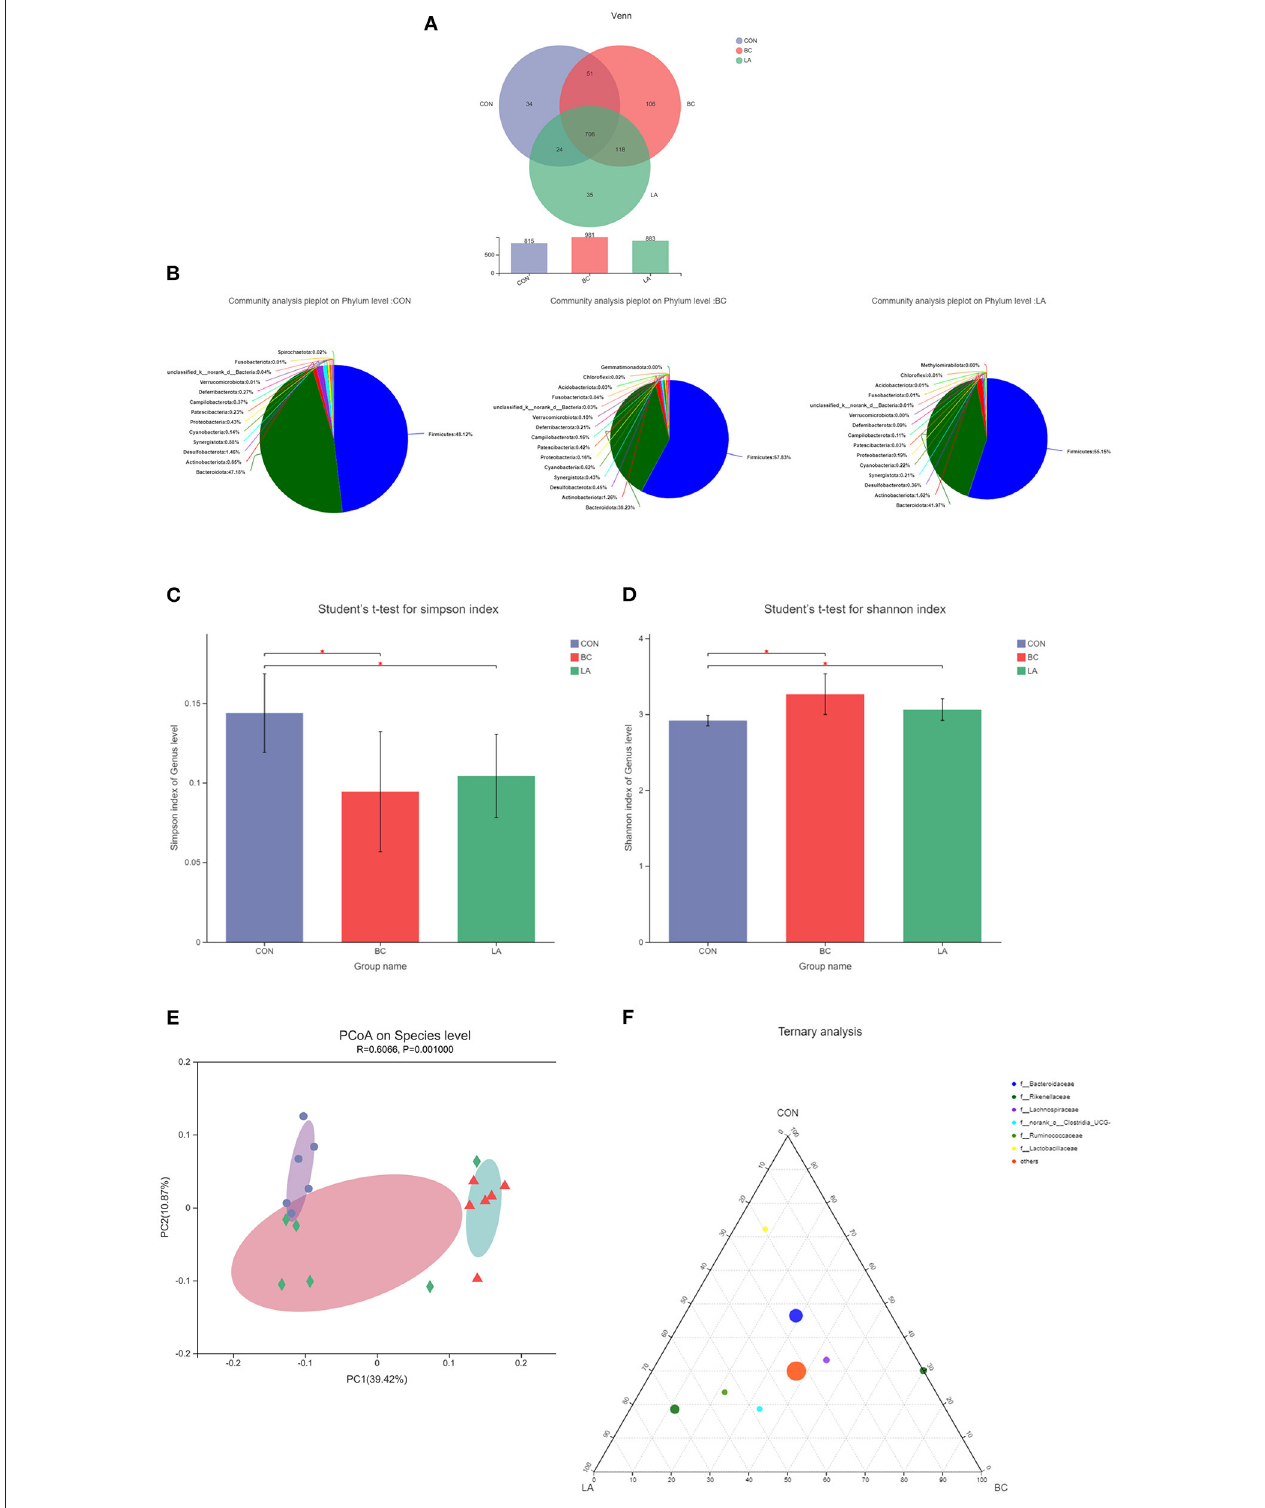
FIGURE 8 | Effects of probiotics on cecal microbiota composition of LPS-attacked broilers. (A) OUT, (B) community composition, (C) simpson index, (D) shonnon index, (E) PCoA analysis, (F) ternary analysis. CON, broilers were not treated except for the base diet; BC, broilers were supplemented with Bacillus coagulans ; LA, broilers were supplemented with Lactobacillus plantarum ; “ * ” means significantly difference. N = 6.